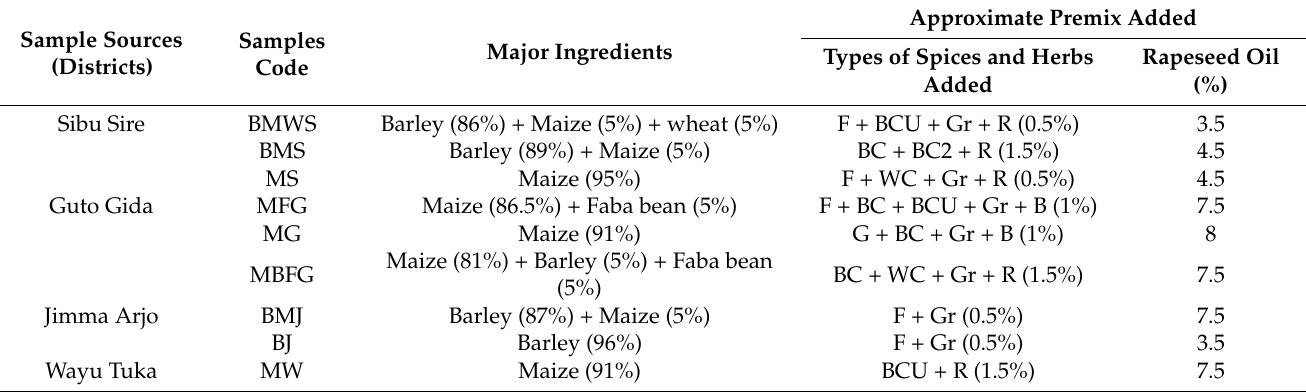
Table 1. Sample collection sites and the ingredients used for the preparation of Shameta samples, East Wollega Zone,